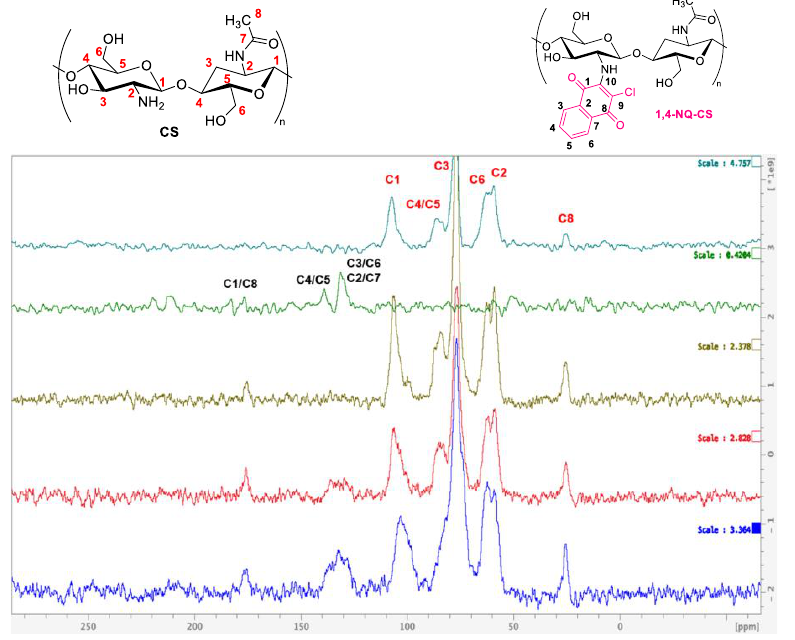
Figure 10. 13 C Solid State CP/MAS-10KHz NMR (125 MHz) spectra of chitosan (light green), 1,4-NQ (green), 1,4-NQ-CS obtained by method a (brown), 1,4-NQ-CS obtained by method b (red) and 1,4-NQ-CS obtained by method c (blue).